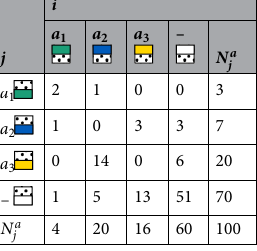
Table 1. Contingency table summarizing the connections of agents i and j over 100 events, also illustrated in Fig.